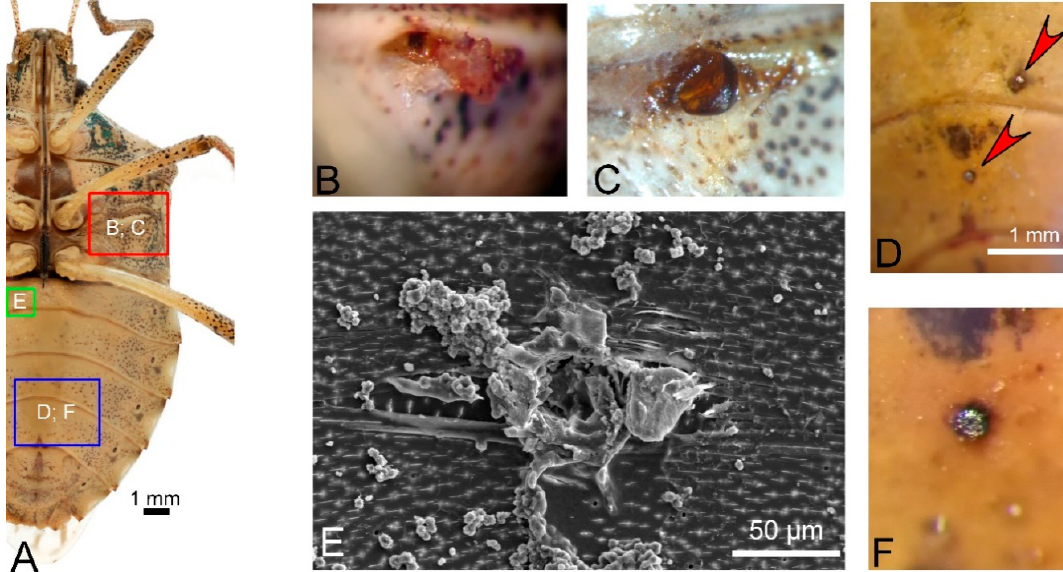
Figure 2. Stereomicroscope ( A – D , F ) and SEM ( E ) images showing marks of cannibalism in the ventral part of overwintering Halyomorpha halys . ( A ) The red square identifies the peritreme, median furrow, and ostiole of the scent gland area, and the green and blue squares highlight abdominal segments. Letters within squares refer to the position of the figures. ( B ) Holes with tissue and haemolymph residues. ( C ) Haemolymph clot. ( D ) The red arrows show the holes in the abdomen. ( E ) SEM image of the hole in the abdomen. This picture represents the same individual in Video S2. ( F ) Close-up image of the holes in D.